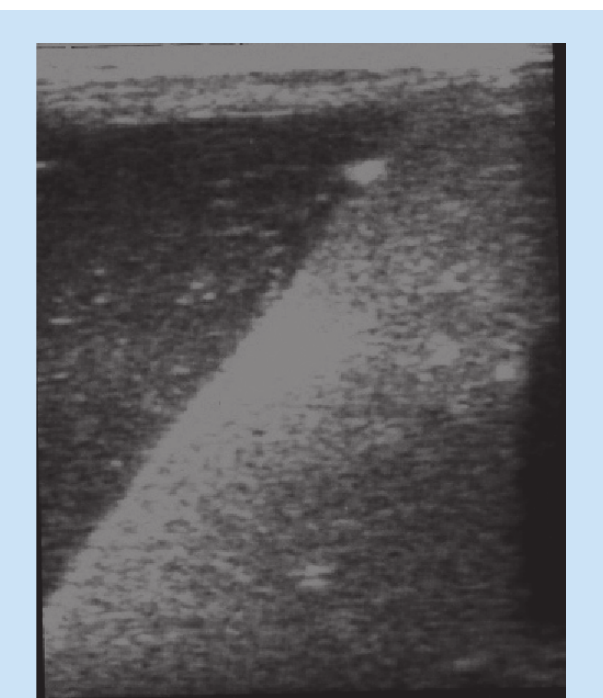
Fig. 3. High-resolution abdominal sonar showing echogenic foci in keeping with calcifications at the periphery of organs.